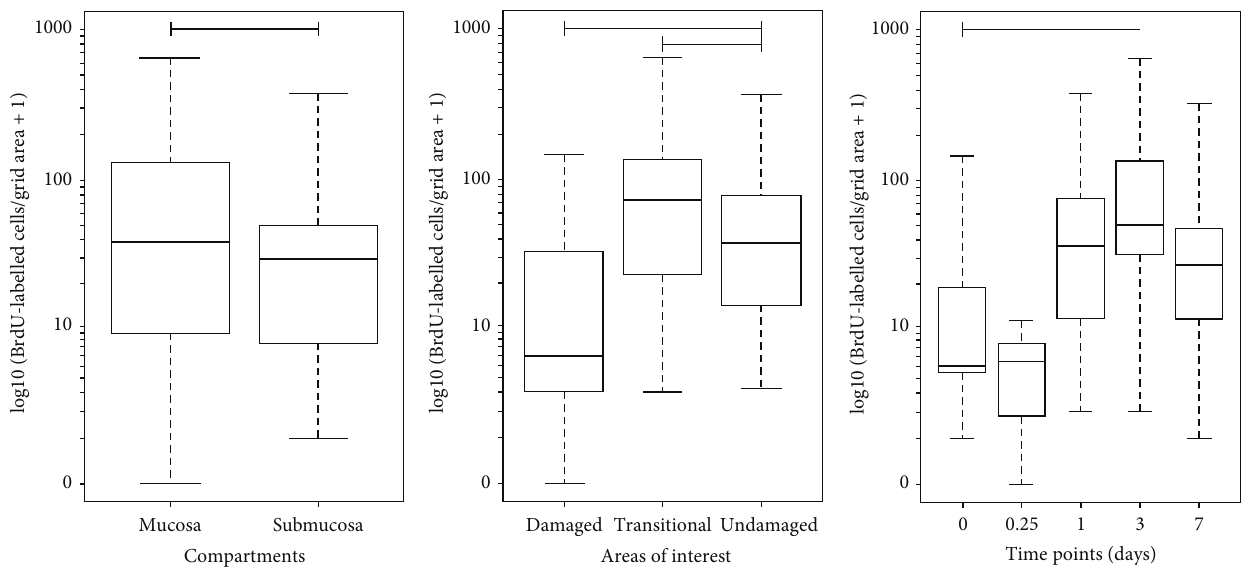
Figure 2: Distribution of BrdU-positive cells. Boxplot illustrating the numbers of BrdU cells counted in the airway tissues, separated by compartment, area of interest and time points. Overall cell counts were significantly greater for the mucosal versus submucosal ( 𝑃 < 0.001 ) compartments and for the damaged and transitional relative to the undamaged areas of interest. There was an increase in the numbers of BrdU-positive cells at day 3 post injury as compared to the na¨ıve (time point 0) ( 𝑃 = 0.004 ). Upper and lower box plot margins represent the interquartile range; middle bar indicates the median. The points outside the ends of the whiskers are outliers. The graph was plotted based on the absolute number of cells stained with BrdU on each area measured. Arrows show BrdU-positive cells.